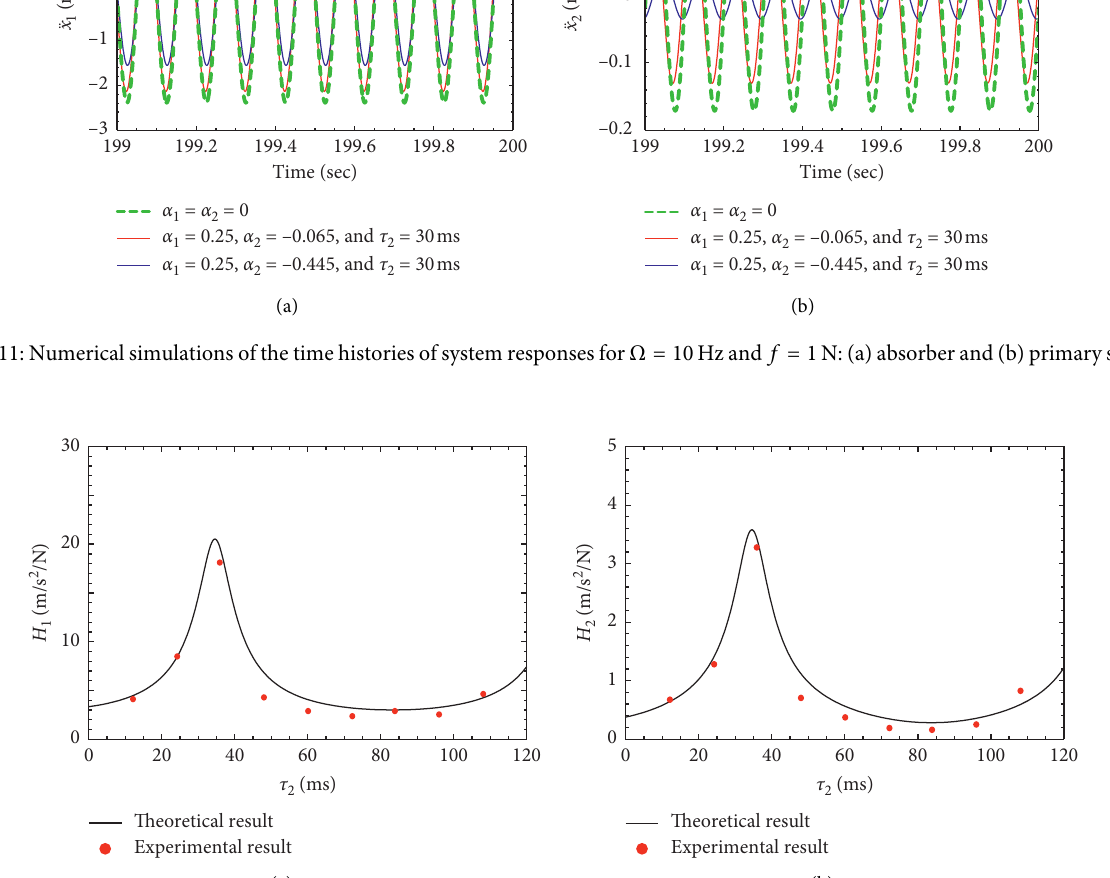
( i � 1 , 2 ) versus τ i